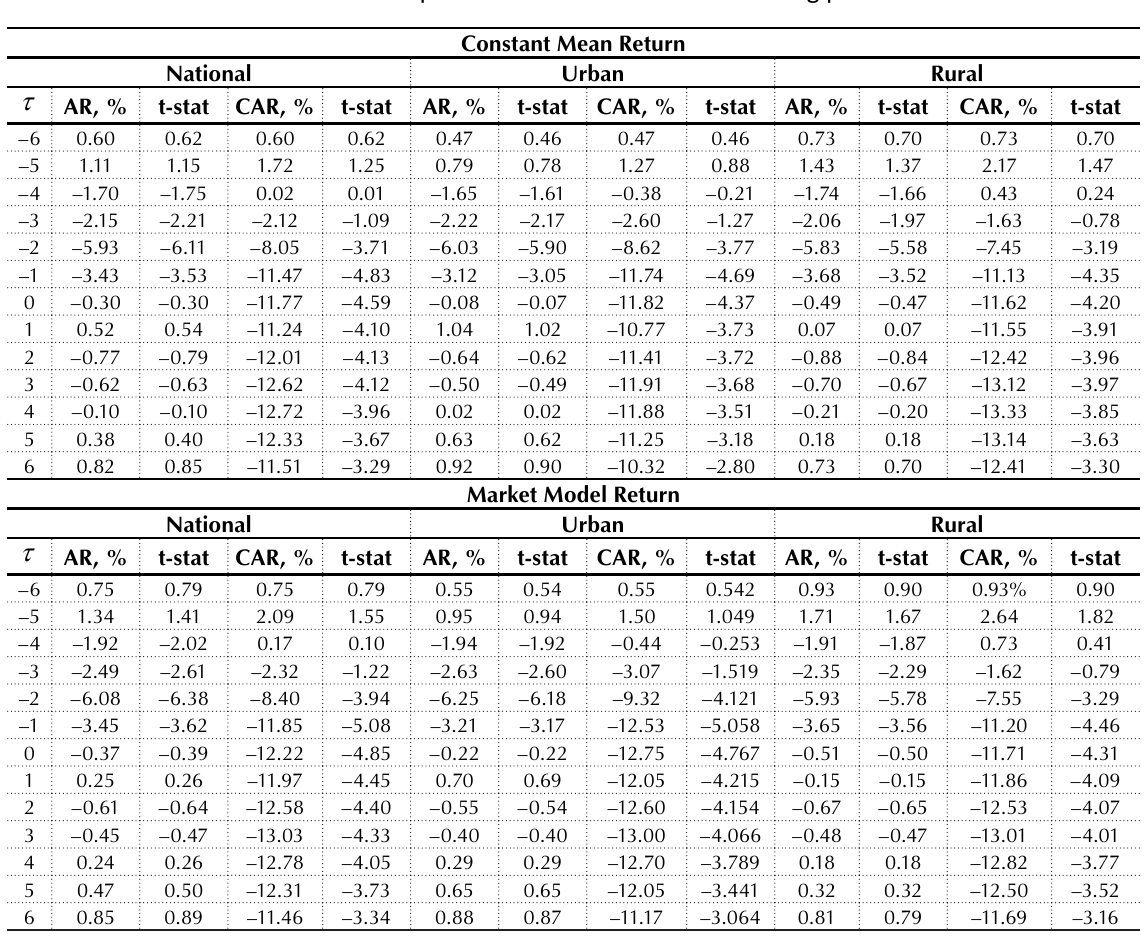
Table 1. Effect of the introduction of personal income tax law on housing